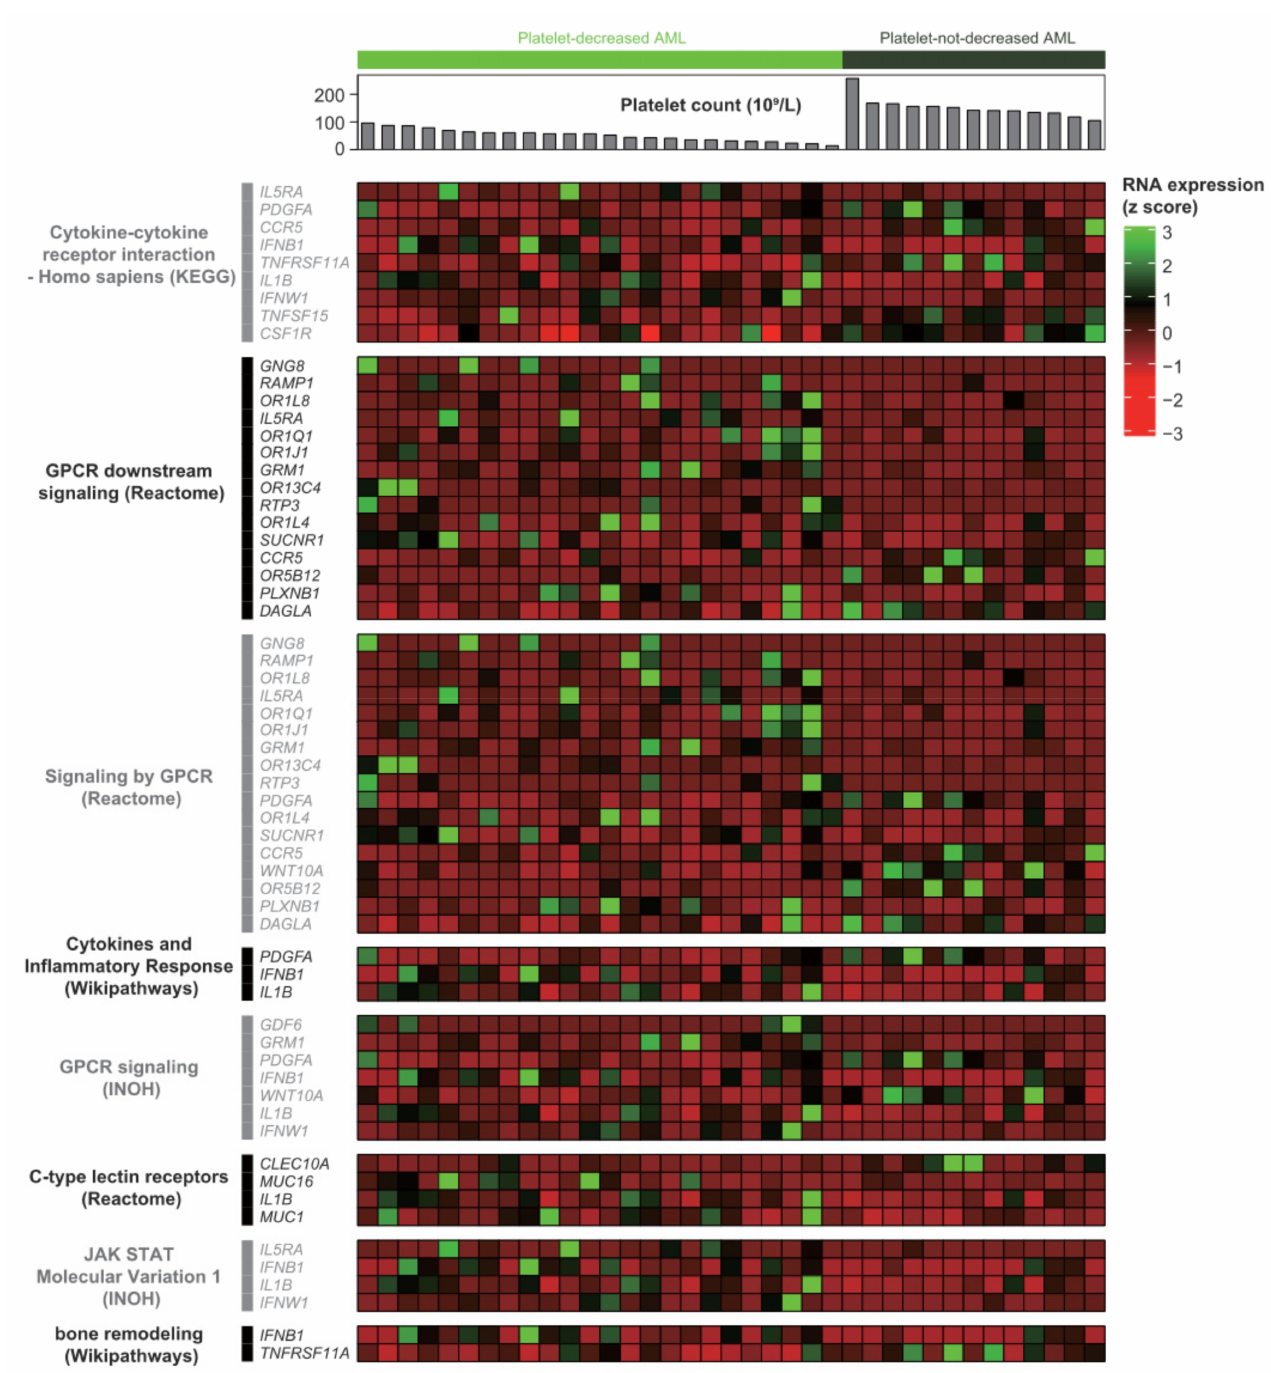
Figure 1. Cell signaling pathways and component genes altered in the RNA level. All the pathways were significantly altered ( q < 0.05). The most altered cell signaling pathway was cytokine–cytokine receptor interaction ( q =